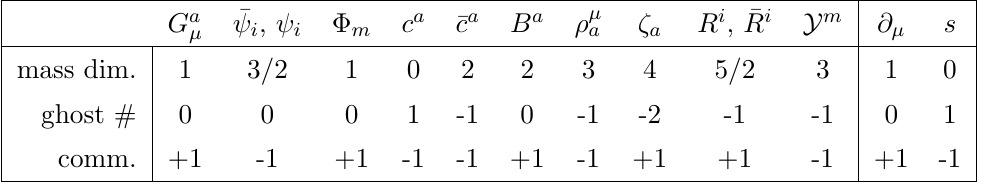
which is a more explicit version of eq. (A.15) from [62]. The generators T Ra verify T Ra y = T Ra , and from them the conjugate representation R is de(cid:12)ned with generators T Ra T Ra T = T Ra (cid:3) . The complex-conjugate counterpart of this equation is (cid:17) (cid:0) (cid:0)